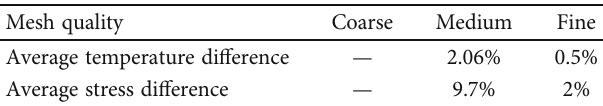
Figure 10: Comparison of Von Mises stress for three di ff erent mesh densities to test the mesh independence. Table 5: Average di ff erences of temperature and stress of three di ff erent types of